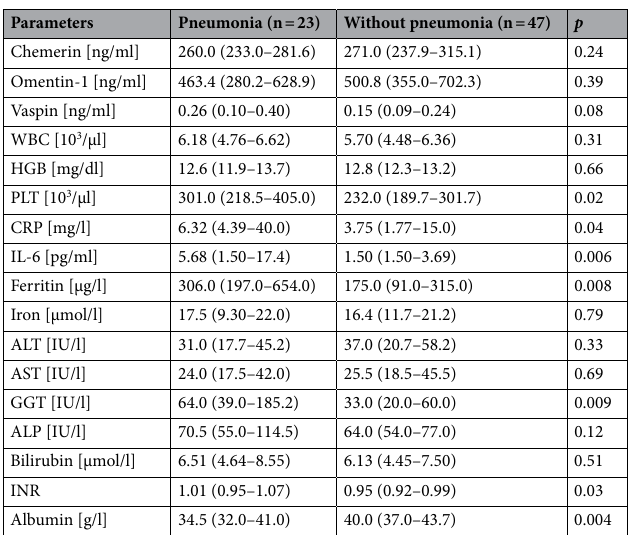
Table 6. Comparison of analyzed parameters between patients with and without pneumonia.